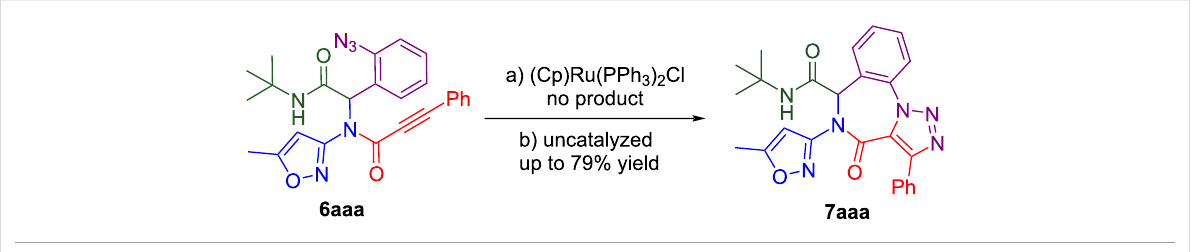
Table 1: Optimizing the reaction conditions for IAAC on internal alkynes.